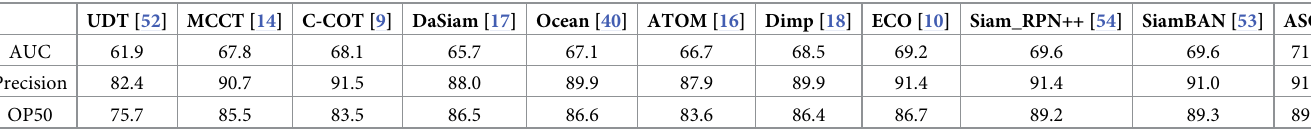
Table 1. Comparisons on OTB2015